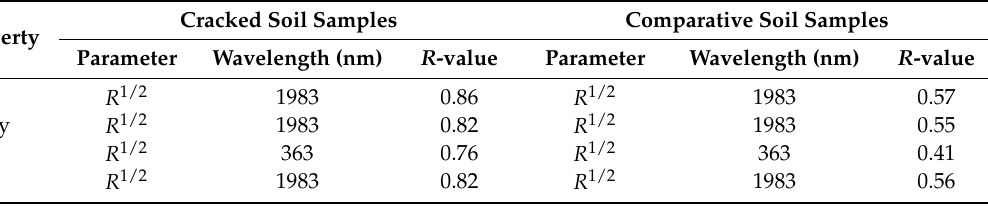
Table 7. Optimal spectral parameters and corresponding wavelengths for different soil properties of soil samples.